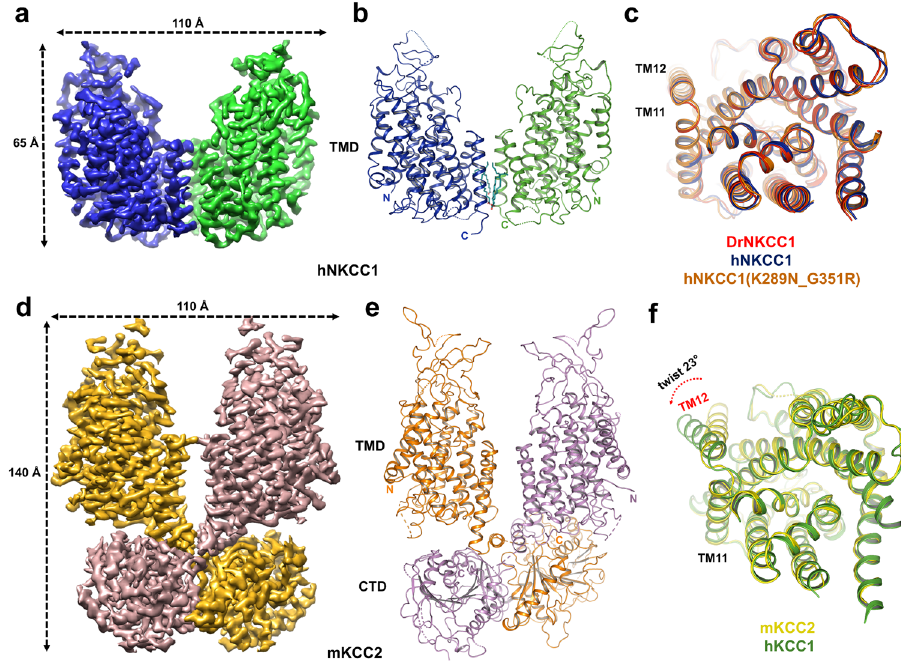
Fig. 1 Structures of hNKCC1 and mKCC2. a Cryo-EM map of the high-resolution hNKCC1 from a side view with each subunit color-coded (blue and green). b Ribbon representation of the high-resolution hNKCC1 from a side view with each subunit color-coded (blue and green). c The TM-domain of the DrNKCC1 (red), previous reported hNKCC1(K289N_G351R) (brown), and the current hNKCC1 (blue) NKCC1 single monomers are superimposed. Top view (from the extracellular side). d Cryo-EM map of the dimeric mKCC2 from a side view with each subunit color-coded (yellow and brown). e Ribbon representation of the dimeric mKCC2 from a side view with each subunit color-coded (yellow and brown). f Superimposition of single monomers of hKCC1 (green) and mKCC2 (yellow) in the TMD demonstrates good alignment (RMSD of 0.69 Å over 341 C α atoms) except for the TM12 helix which is tilted 23° in hKCC1 compared to